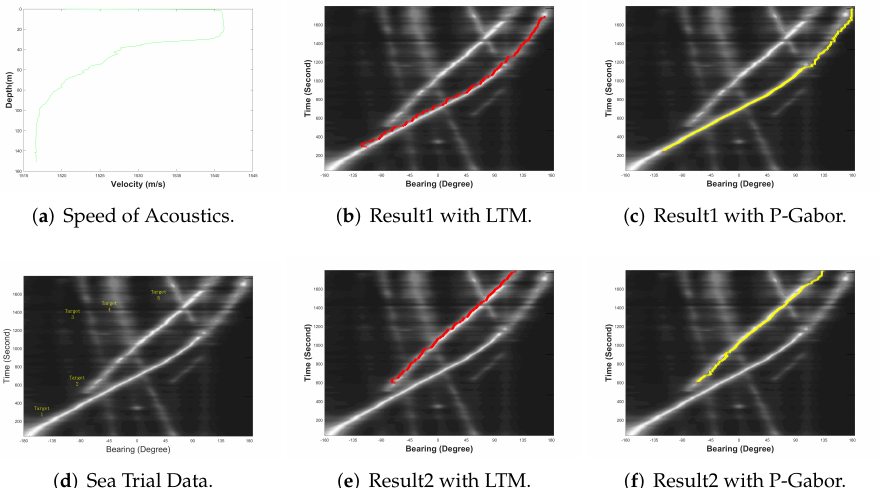
Figure 12. Experiment results with weak jamming targets.